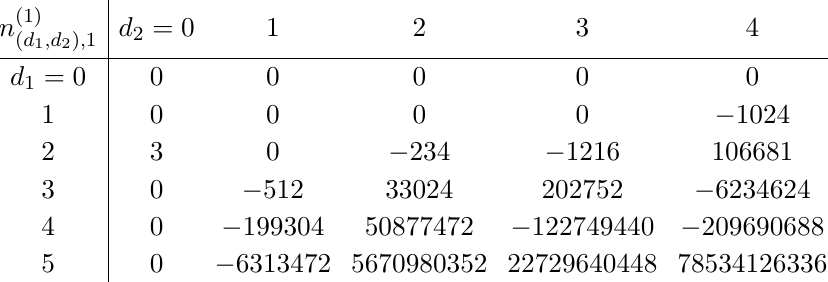
with Z charge 1 . 2 2